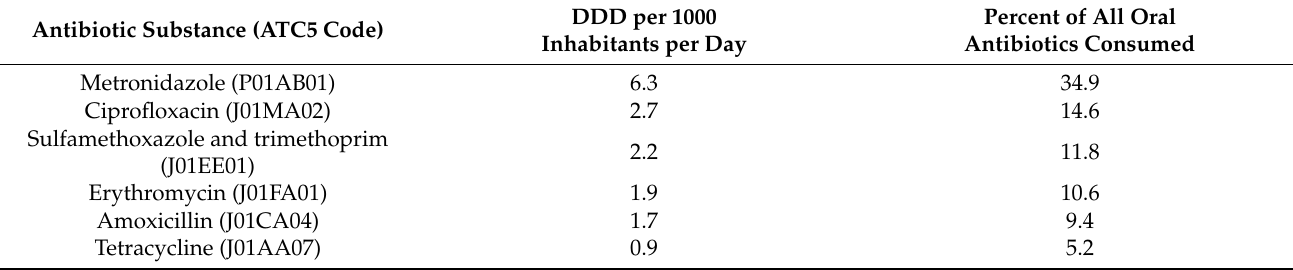
Table 3. Top ten most commonly used oral antibiotics (J01, by ATC5) in relation to DDD per 1000 inhabitants and their percentage of all oral antibiotics consumed in Sierra Leone,